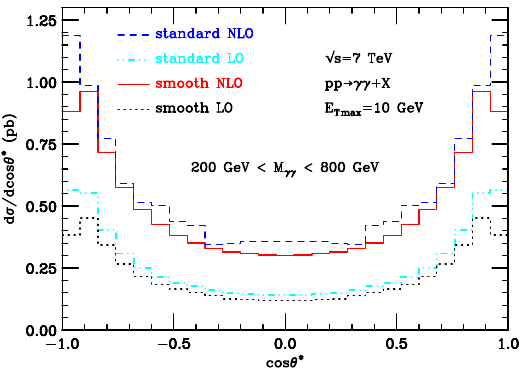
Figure 5 . The cos θ ∗ differential cross section for E T max = 10 GeV and with the constraint 200 GeV < M γγ < 800 GeV in addition to the same photon kinematical cuts as in figure 4. The results, which are obtained with the scales µ R = M γγ / 2 and µ F = µ frag = 2 M γγ , are as follows: LO smooth isolation (black dotted), LO standard isolation (light-blue dash-dotted), NLO smooth isolation (red solid) and NLO standard isolation (blue